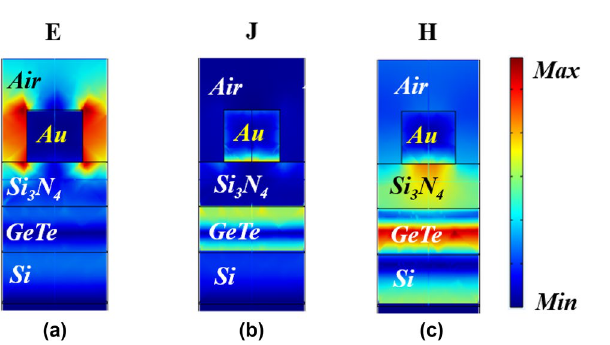
Figure 7. Absorption map in relation to the thickness of golden square ( h Au ) scanning for ( a ) amorphous; ( b ) semi-crystalline and; ( c ) crystalline phases.